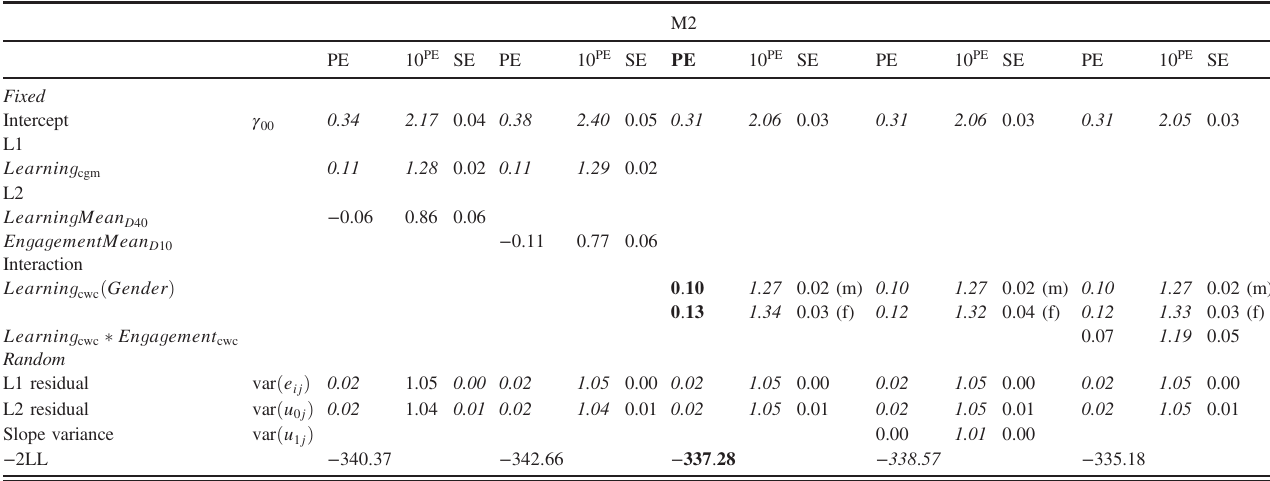
TABLE XII. Second half of hierarchical linear modeling results with LOG10(accelerants) as the outcome. All statistically significant parameter estimates (PE and 10 PE ) are written with cursive. The − 2 LL was used to compare same models with and without slope variance; italic font indicates better fit. The bolded column M2 is the best fitting model considering all L1, L2, and interaction terms and